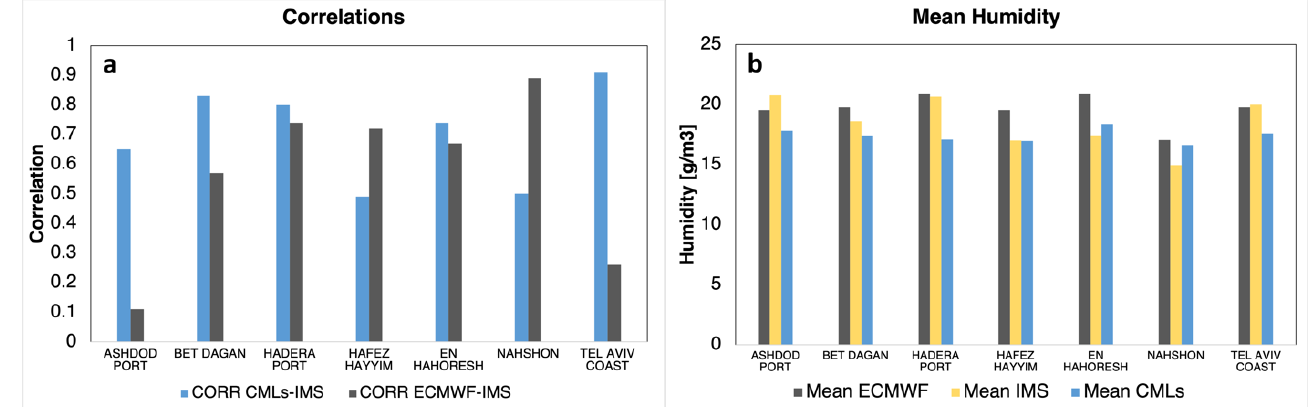
Figure 3. ( a ): Correlations between the CMLs and the reanalysis from the ECMWF (ERA5) and the Israeli Meteorological Service (IMS). ( b ): Mean absolute humidity values in [g/m 3 ] from the CMLs, ECMWF (ERA5), and the IMS. All results refer to observations made during July 2017 of one instantaneous measurement at 3 am. Detailed information and additional results can be found in Table